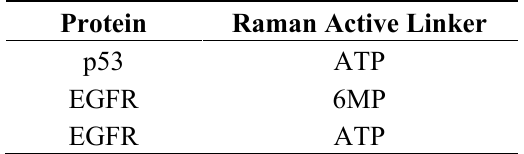
Figure 2. Functionalization of a Ag nanopillared substrate with linker and covalently bound antibody. With increasing amounts of target antigen, we observe a shift in the CS peak to longer wavenumbers and a corresponding decrease in the FWHM, resulting from increased mechanical stress in the system. Table 1. Protein-Linker model systems